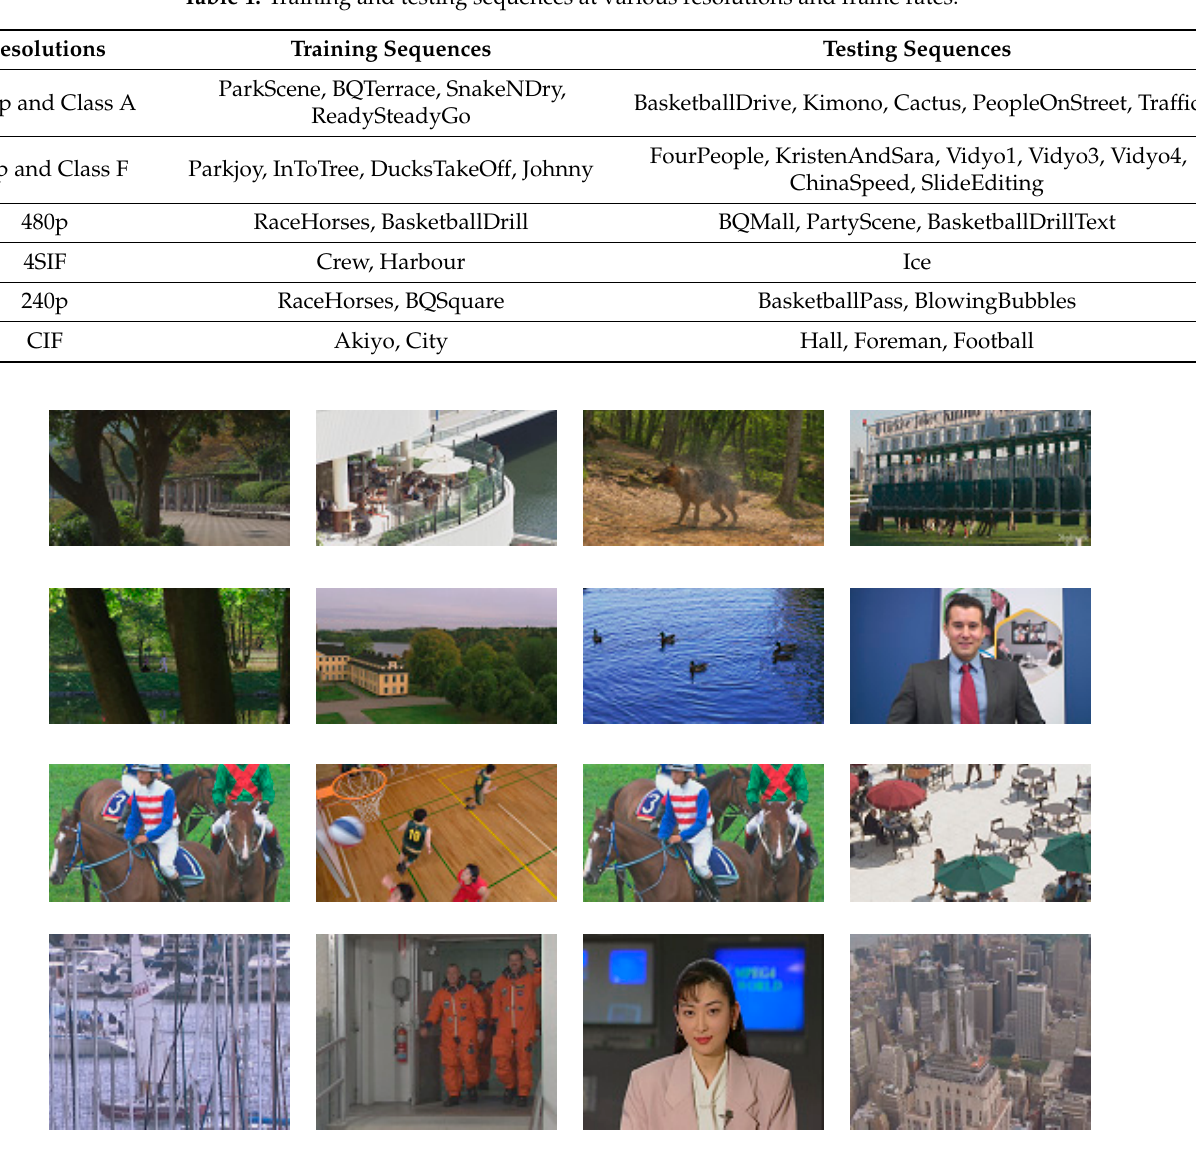
Figure 6. Illustration of the first frame of training videos. From left to right, top to bottom: ParkScene, BQTerrace, SnakeNDry, ReadySteadyGo, Parkjoy, InToTree, DucksTakeOff, Johnny, RaceHorses, BasketballDrill, Crew, Harbour, RaceHorses, BQSquare, Akiyo, City.